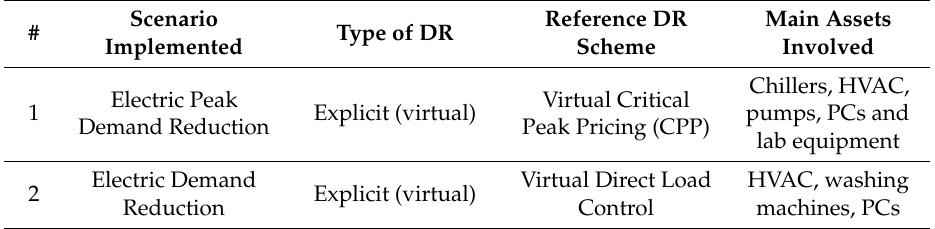
Table 4. DR scenarios and scheme implemented in the Romanian pilot